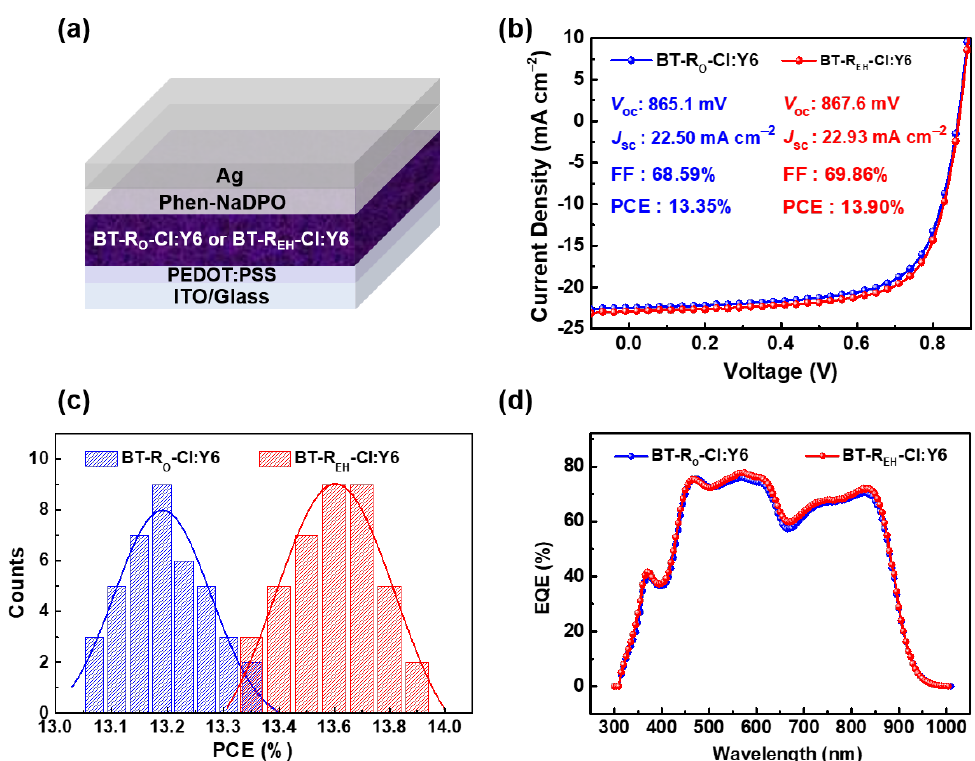
Figure 3. ( a ) The device structure; ( b ) J – V curves of the optimal devices; ( c ) statistical diagram of PCE counts for 40 individual devices; and ( d ) EQE curves of the optimal devices.